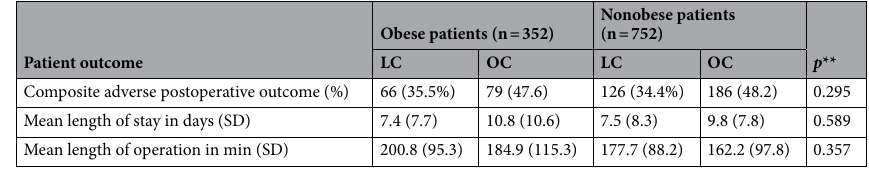
Table 5. Effect of laparoscopic versus open colectomy by obesity, NSQIP 2013–2015.* *Obese: ≥ 30 kg/ m 2 ; ** p < 0.05 based on propensity score-matched patients comparing obese versus nonobese patients. LC: laparoscopic colectomy; OC: Open colectomy; SD: standard deviation. Composite outcome includes readmission, reoperation, wound infection, blood transfusion, prolonged ileus, sepsis, myocardial infarction, deep vein thrombosis, pulmonary embolism, and